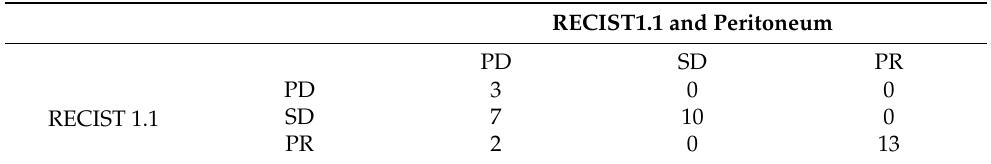
Table 1. An outline of our patients would be classified considering RECIST 1.1 with or without adding the peritoneal assessment. Note that 9 patients (25%) would have been reclassified. RECIST1.1 and